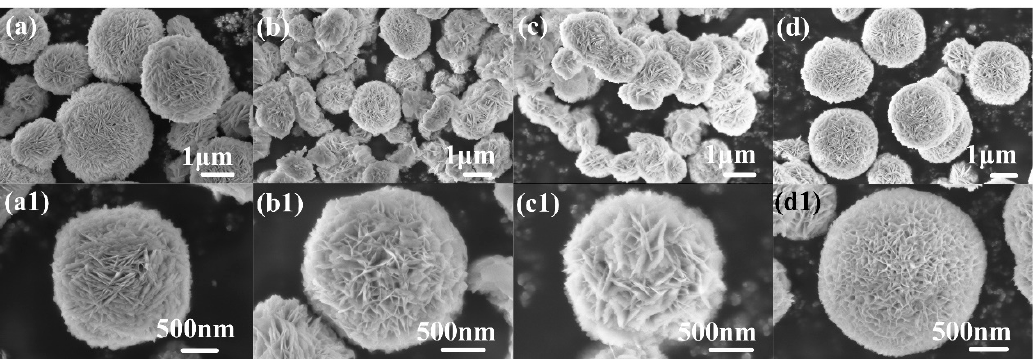
Figure 1. FESEM and HRSEM images of BiOBr ( a , a1 ), Bi 1 − x Cd x OBr ( b , b1 ), Bi 1 − x Fe x OBr ( c , c1 ), Bi 1 − x − y Cd x Fe y OBr ( d , d1 ).